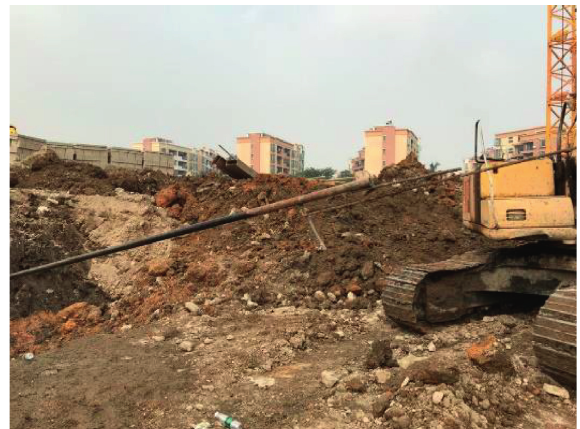
Figure 15: Recycle of the polycystic aeration bolt.